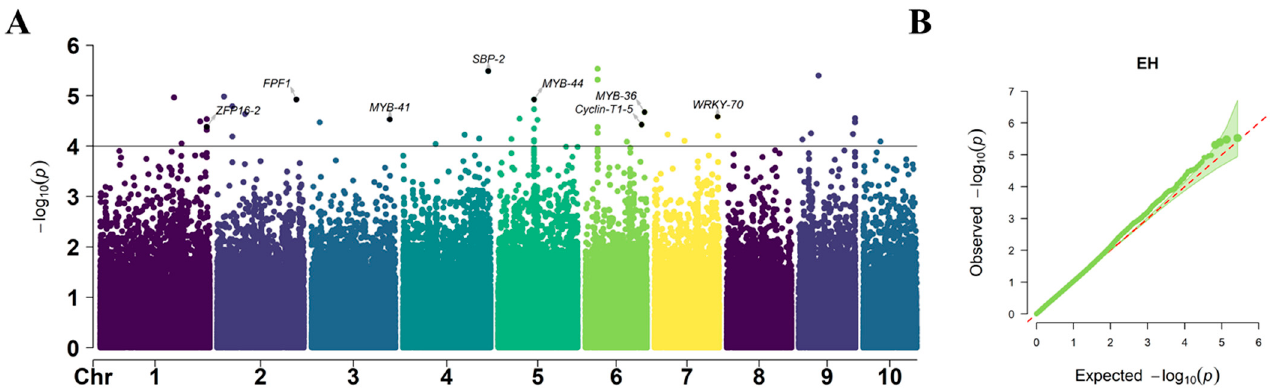
Figure 7. Manhattan plots of GWAS results showing the significant SNPs associated with EH traits. ( A ) Manhattan plot. Each dot represents a SNP. The black solid line represents the threshold of 1 × 10 –4 . ( B ) Quantile–Quantile (Q–Q) plots. The red line is the trend line to which the ideal Q–Q plot in each case should correspond.